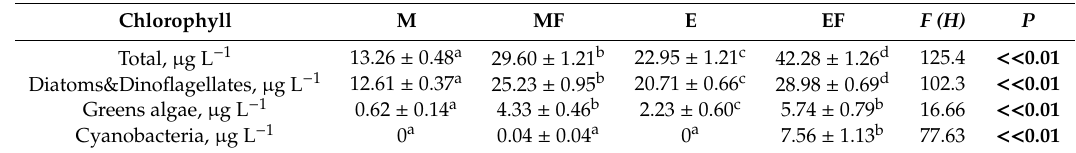
Table 9. Results of one-way ANOVA comparing means ( ± SE) of chlorophyll concentrations for the period of life-table experiments in E—eutrophic, LE—low-eutrophic, F—fish treatments, F Fisher’s test; P significant values are given in bold; means labeled with the same letter are not significantly di ff erent at P < 0.05 after Fisher’s LSD post hoc test (in the absence of normal distribution, the Kruskal–Wallis test (H) was used).